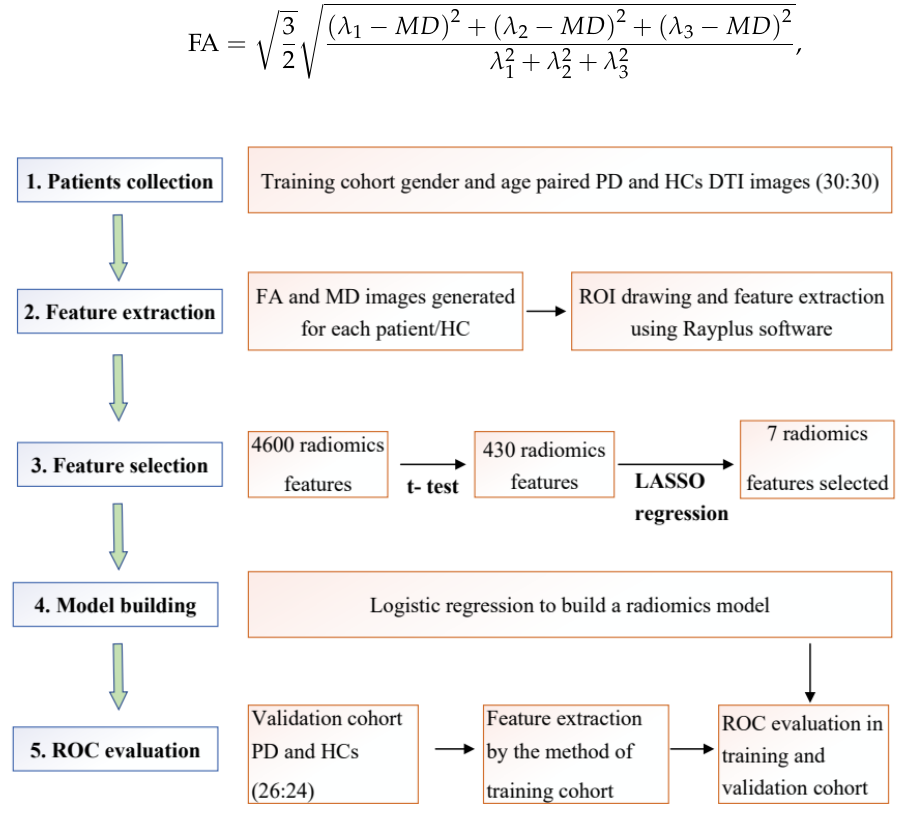
Figure 1. Flow chart for the whole study.